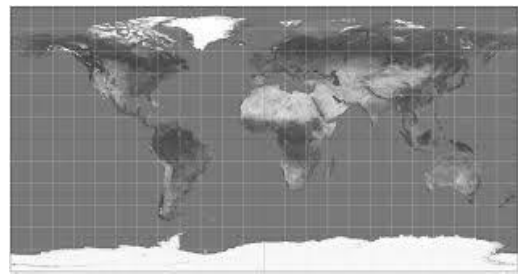
Figure 7: Geographic projection covers the whole Earth with one rectangle. Source: Wikipedia